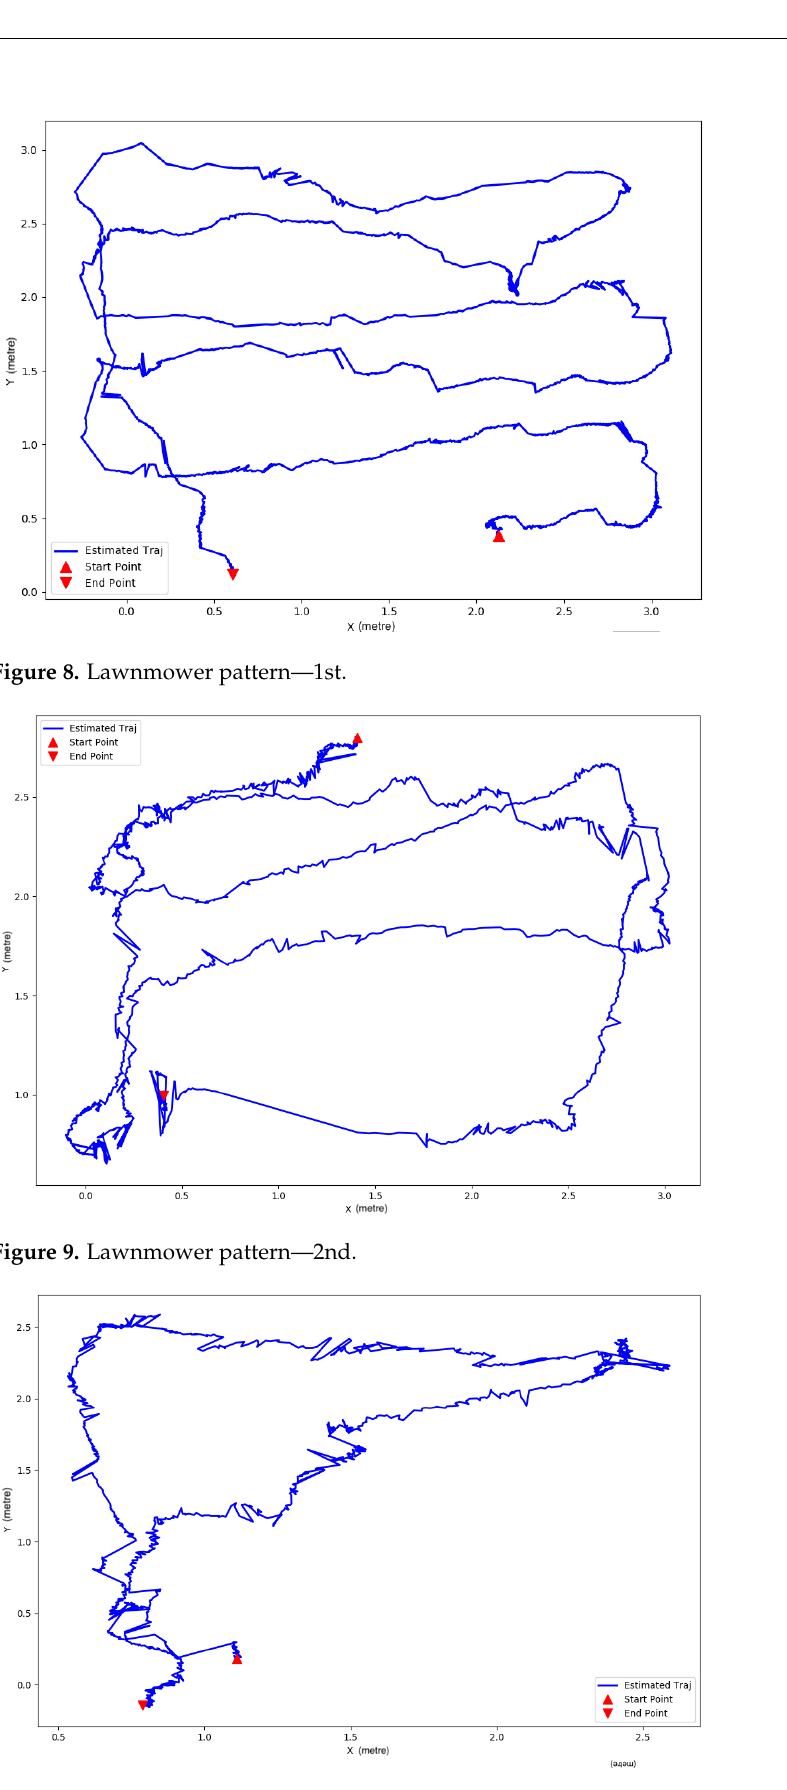
Figure 10. Closed